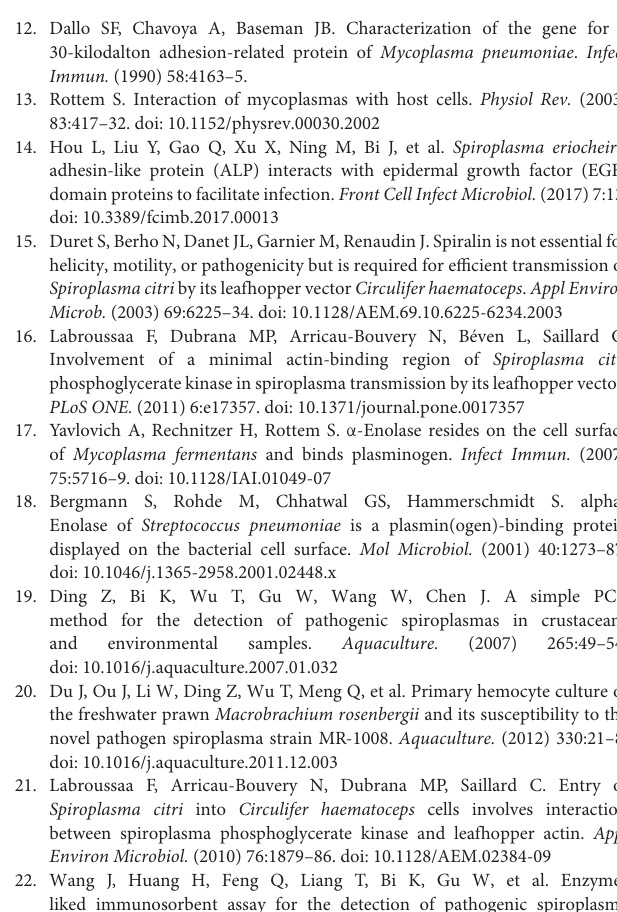
Table S1 | Sequences of primers used in this study. Table S2 | Related outputs obtained from MASCOT analysis. Table S3 | Related outputs obtained from MASCOT analysis. Table S4 | The number of lived prawns. Table S5 | The number of lived prawns. Table S6 | The number of lived